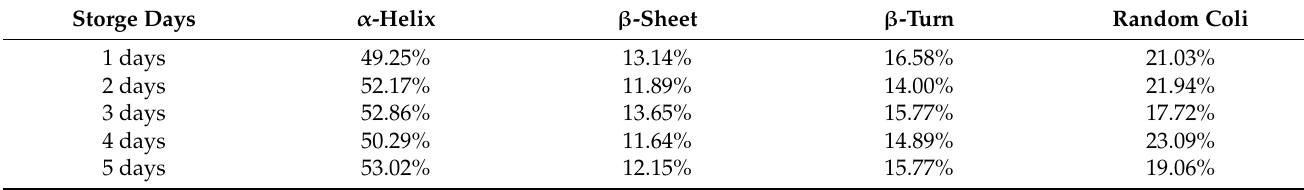
Table 3. Changes in the spatial protein content of rice protein when the relative humidity is 80% and the storage temperature is 35 ◦